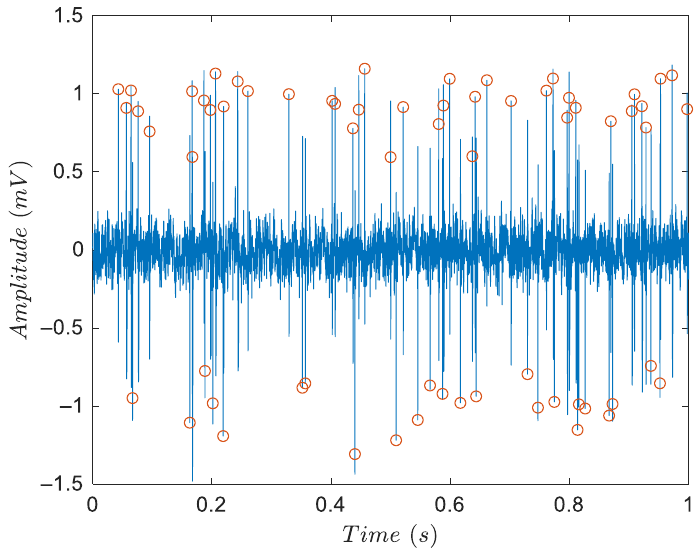
Figure 1. 1 s snapshot of synthetic data of easy1 group with the noise level of 0.1 with arrivals spike stamp highlighted with red circle mark.